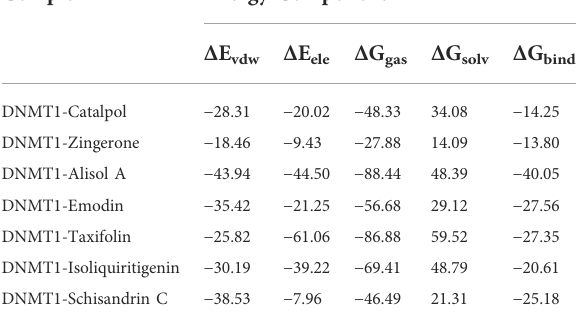
TABLE2 The average of binding free energy of DNMT1 complex obtained using Amber20 (kcal/mol). Complex